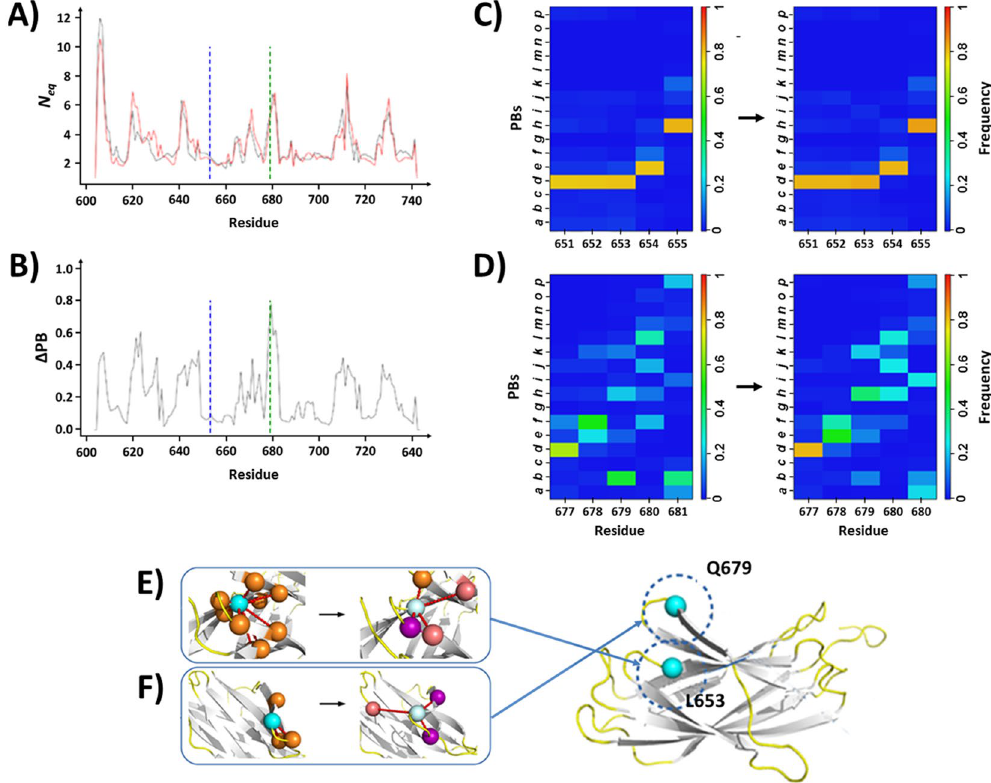
Figure 7. The variant L653R. Panels (A and B) respectively show the N eq and the Δ PB curves of the L653 (WT) and R653 (variant) systems. Panels (C,D) respectively show the PB maps of residues 651 to 655 and 677 to